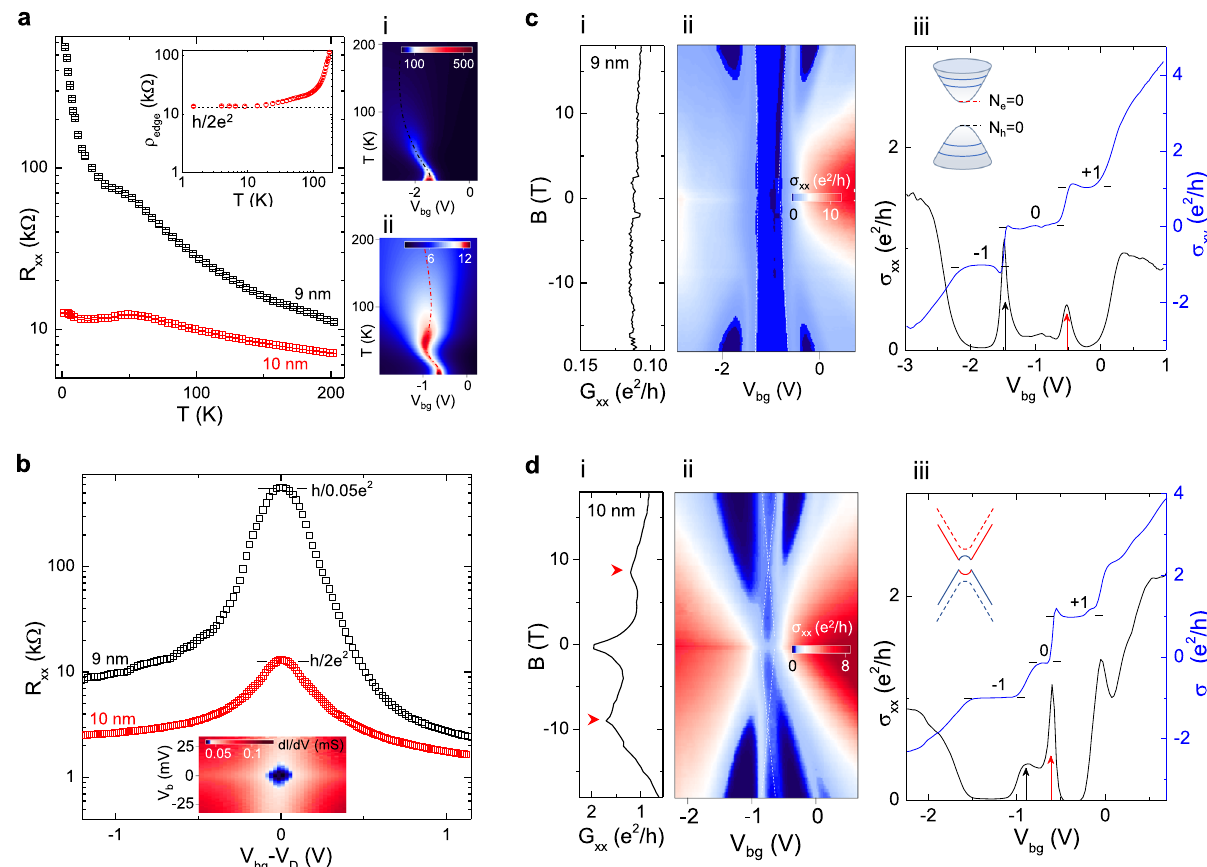
Fig. 3 | Normal and inverted gaps. a R xx versus temperature for the 10nm and 9nmhBSTS.Errorbarsin( a )arethestandarddeviationoftheextracted R xx values. Insetin( a )is ρ edge calculatedforthe10nmhBSTSasafunctionoftemperature.The horizontal dashed line corresponds to h/2e 2 . Right panels in ( a ) are color maps of R xx asfunctions of T and V bg for the (i)9nm and (ii)10nm hBSTS.Unit ofthe R xx is k Ω . Dashed lines in the color maps trace the CNPs at different temperatures. b R xx versus V bg – V D forthe 10nmand 9nm hBSTS. Inset in( b ) is acolor map of dI/dVas function of V b and V bg for the 10nm hBSTS. (i) Plots σ xx and σ xy versus V bg at the magnetic fi eld of 18T for the ( c ) 9nm and ( d ) 10nm hBSTS. Inset in ( c ) is a